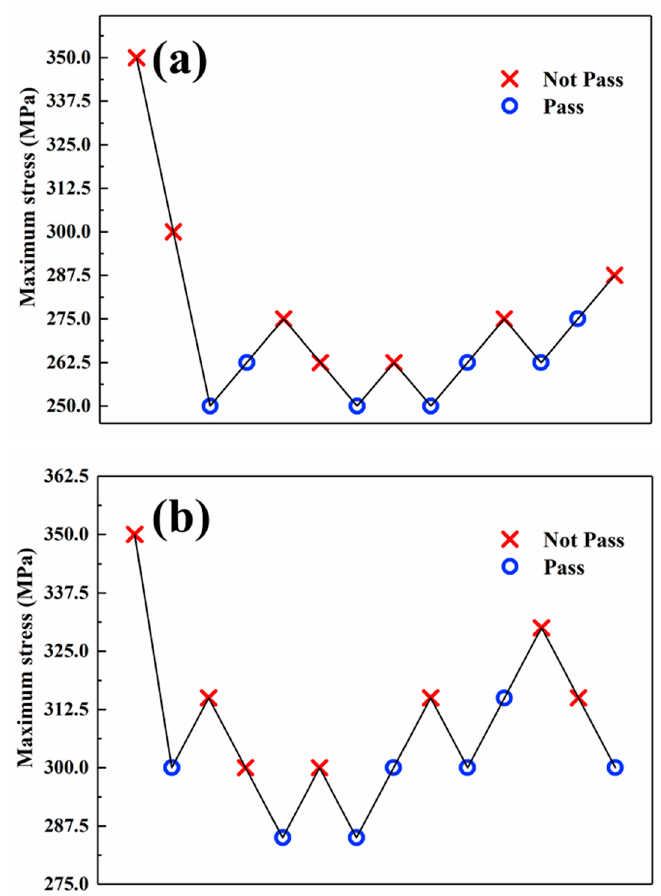
Figure 4. The results of fatigue test of the specimens with and without LSP. ( a ) Untreated; ( b ) LSP-ed.